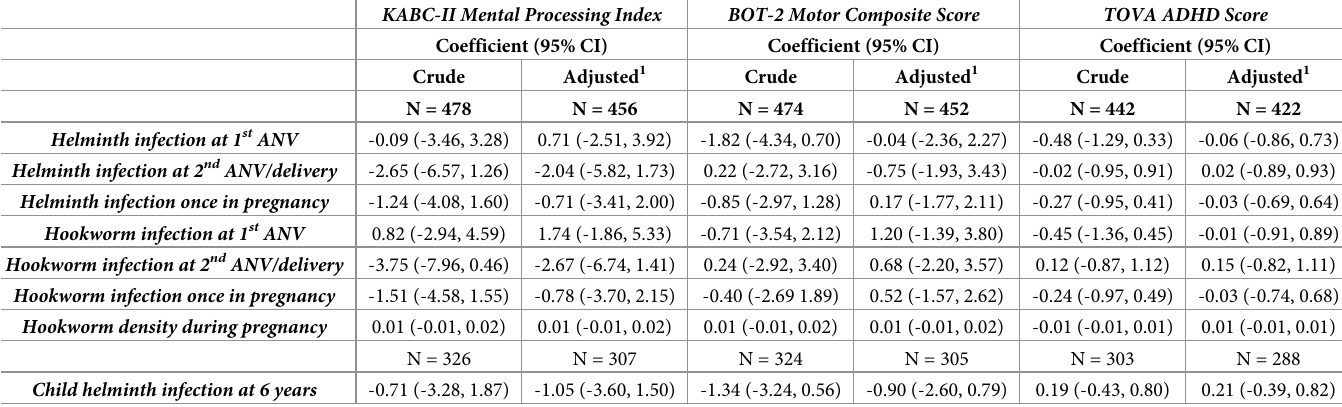
Table 3. Multiple linear regression models between SHIP and child neurocognitive development scores at six years.